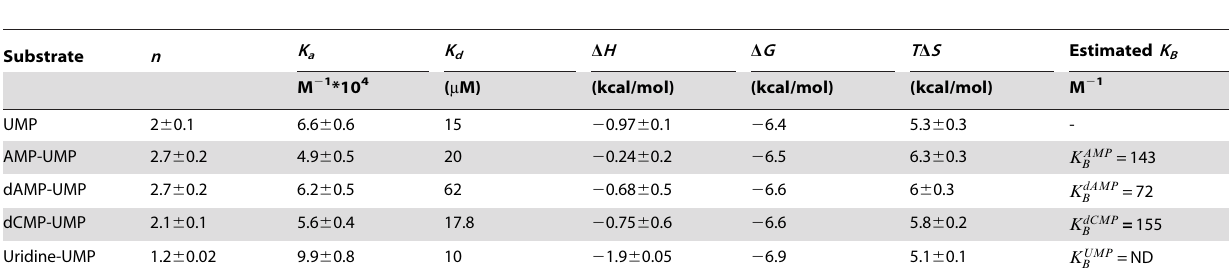
Table 3. The thermodynamic constants obtained by isothermal titration calorimetry for the association of nucleosides with Ago 2 PAZ domain.